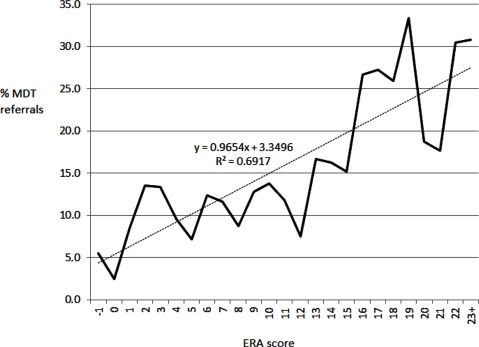
The percentage of multi-disciplinary team referrals recorded for each Elders Risk Assessment Index (solid line) with the linear trendline (dotted).